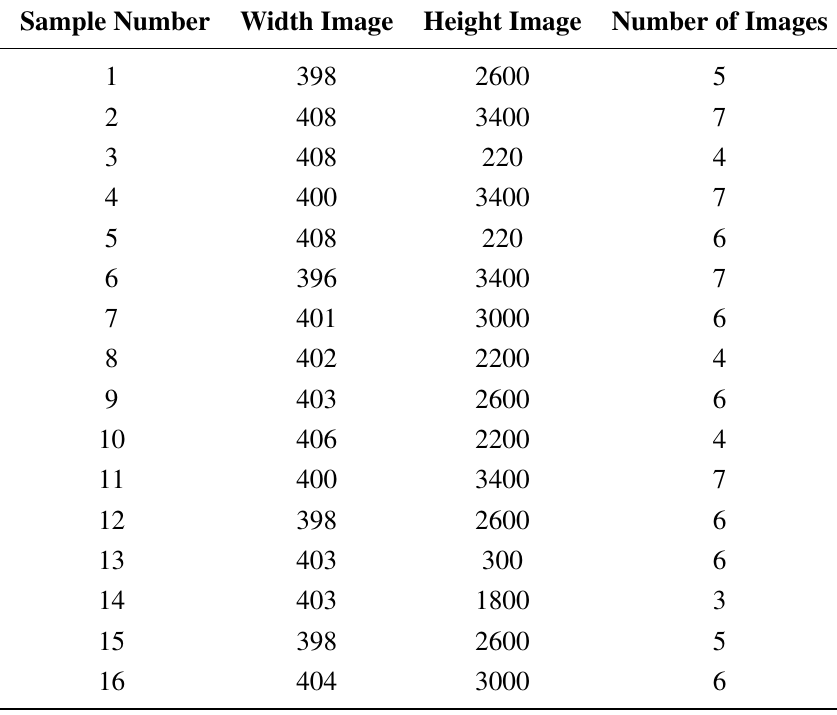
Table 1. Data from the 16 samples used in this